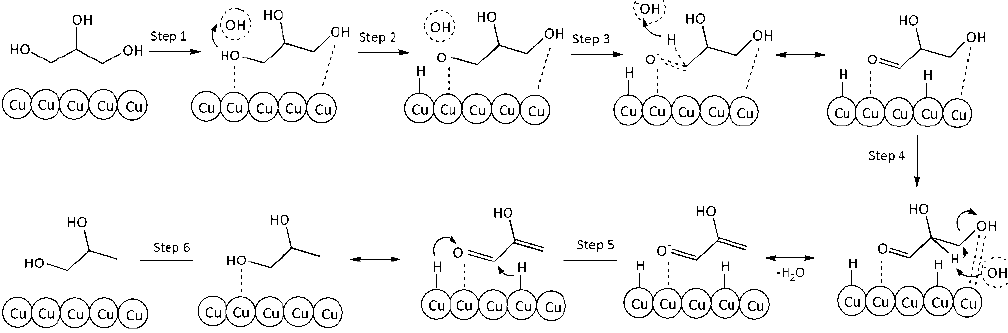
Figure 8. A schematic conversion of glycerol into PG on the catalyst surface.